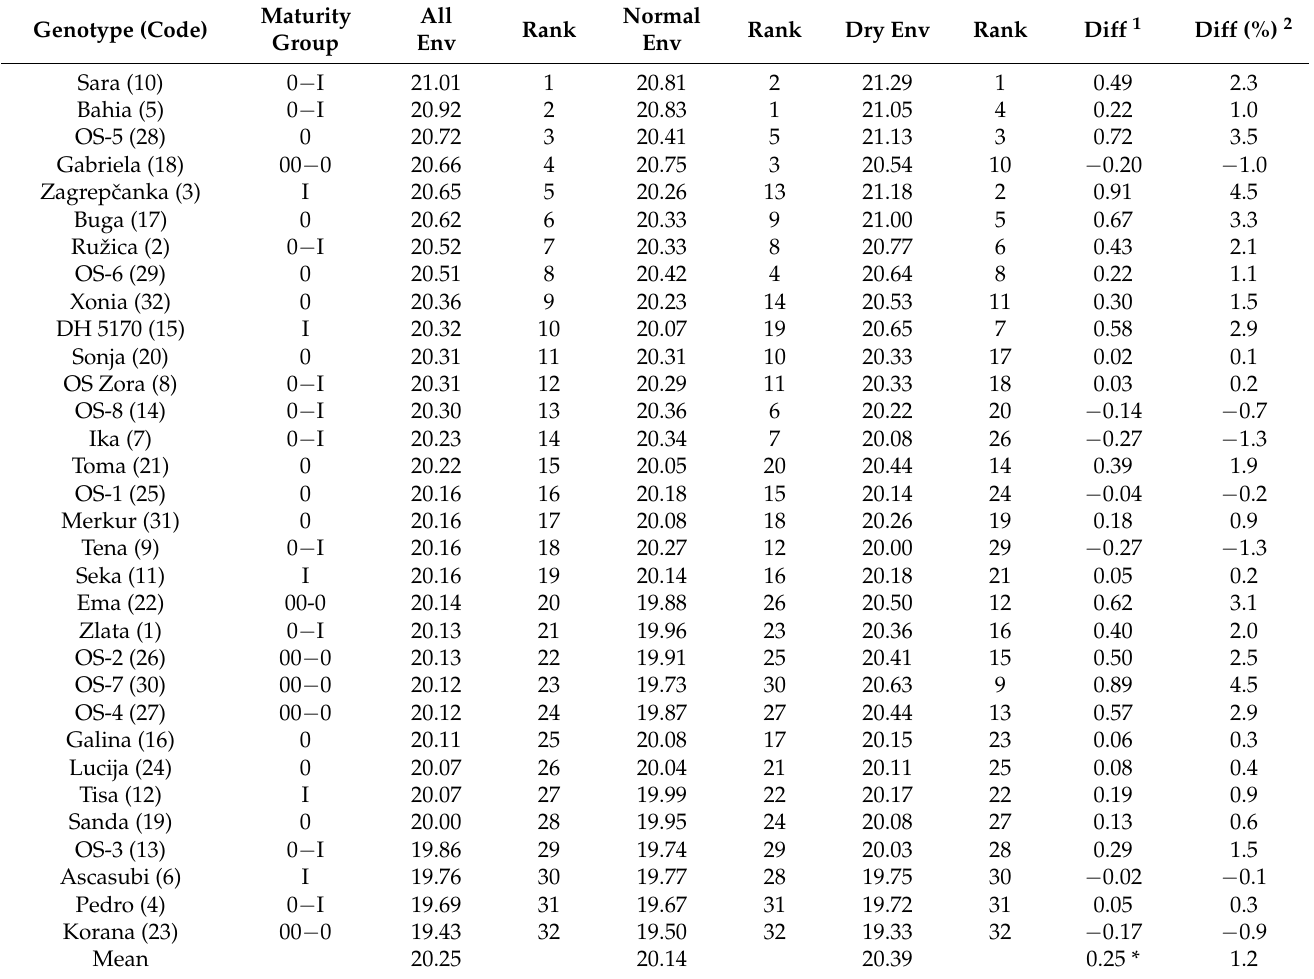
Table 6. Mean oil content (%) of 32 soybean genotypes across all, normal and dry environments with the corresponding ranks within each group of environments. Genotypes are presented in descending order based on their mean values across all